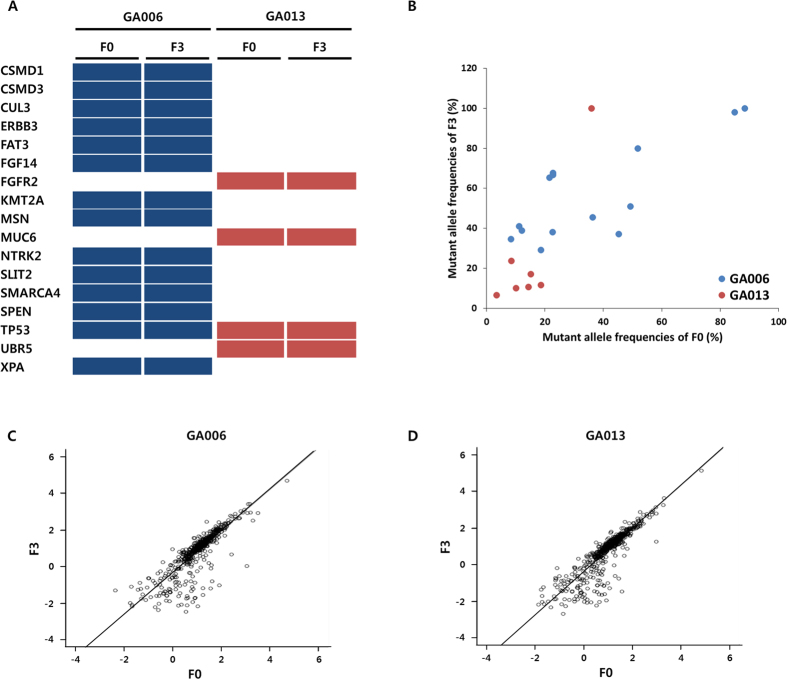
Correlation of genetic features for 726 cancer-related genes between primary and PDX tumours.(A) Mutations in F0 and F3 tumours among 726 cancer-related genes were indicated in GA006 (dark blue bars) and GA013 (red bars) PDX models. (B) Mutant allele frequencies between F0 and F3 tumours for 14 and 7 mutations detected in GA006 (blue dots) and GA013 (red dots) PDX models, respectively. (C,D) The correlation of mRNA expression levels for 726 cancer-related genes in F0 and F3 tumours was represented as scatter plot in GA006 (C) and GA013 (D) PDX models.